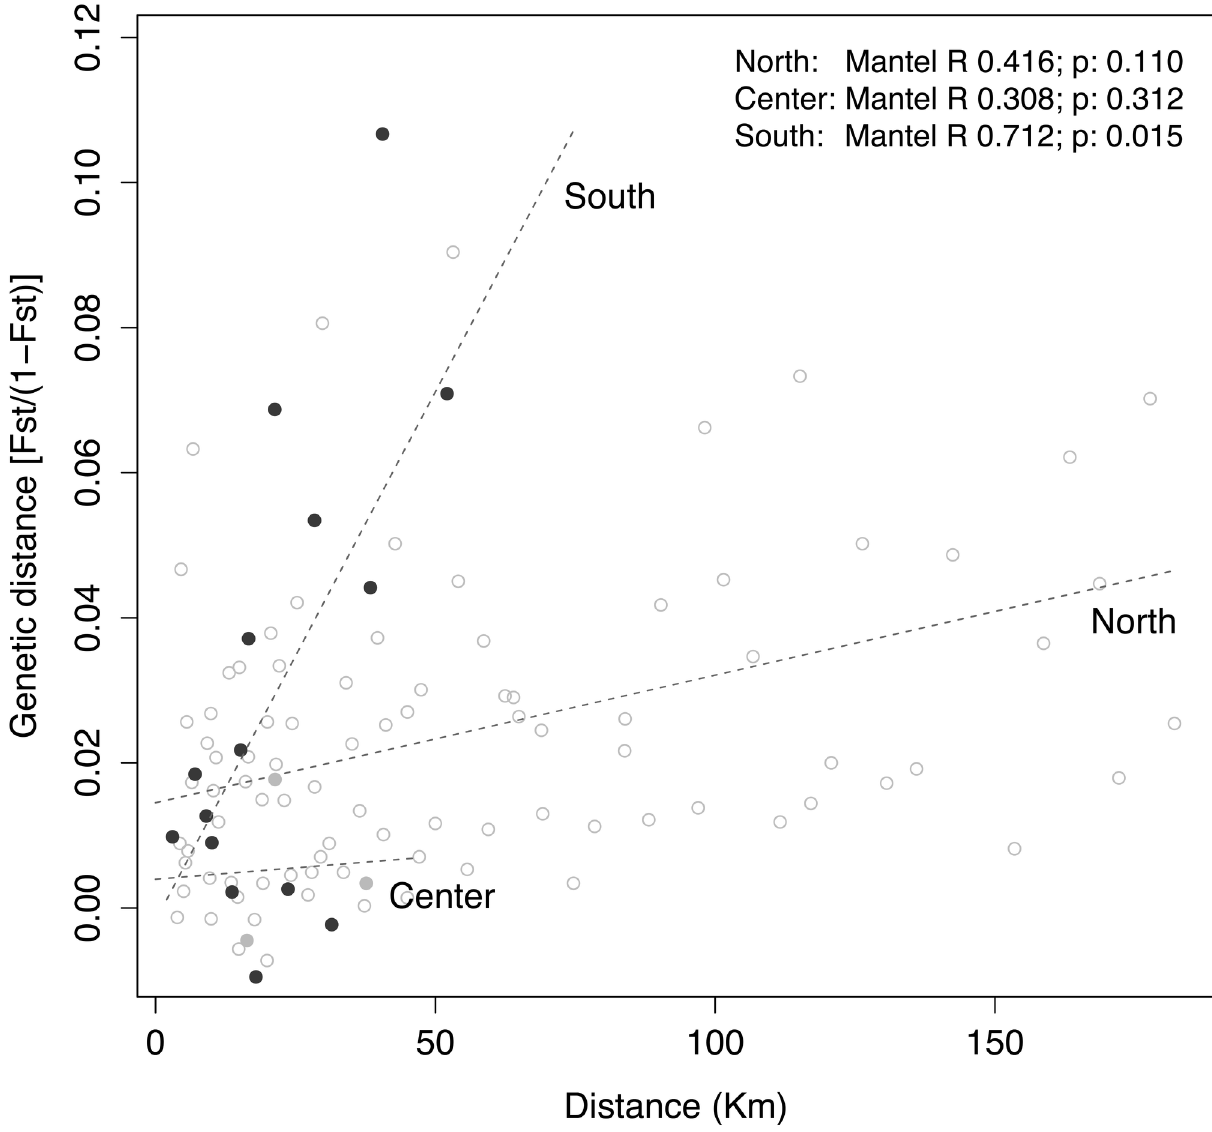
Figure 3. Isolation by distance of S. polyschides . Estimates of pairwise genetic differentiation ( F pairwise minimum site distance in kilometres for (i) northern sites (white circles), (ii) central sites (grey circles) and (iii) southern sites (black circles). Mantel non-parametric tests based on 1x10 5 permutations between pairwise genetic differentiation and pairwise site